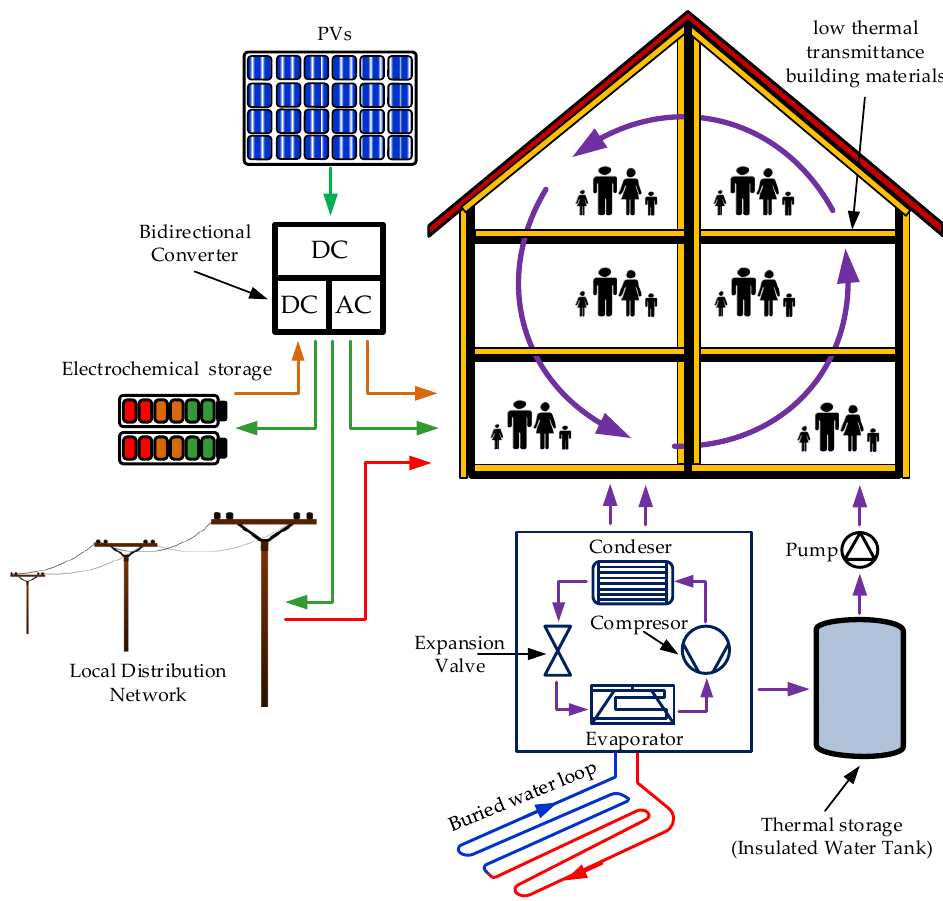
Figure 1. Schematic diagram of the proposed nZEB concept.